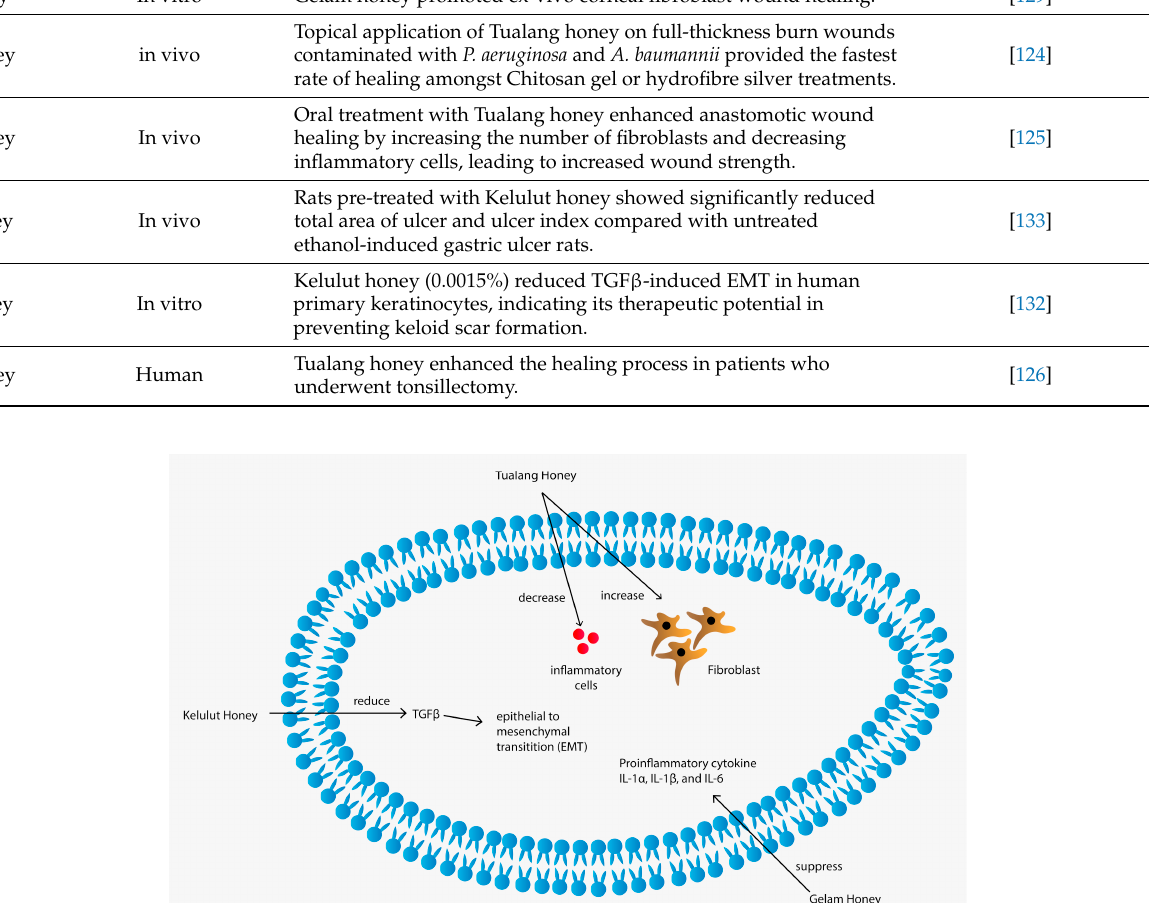
Figure 5. Wound-healing mechanism of Tualang, Gelam and Kelulut honeys. TGF β : transforming growth factor beta; IL- 1 α : interleukin-1 α ; IL-1 β : interleukin-1 β ; IL-6: interleukin-6.